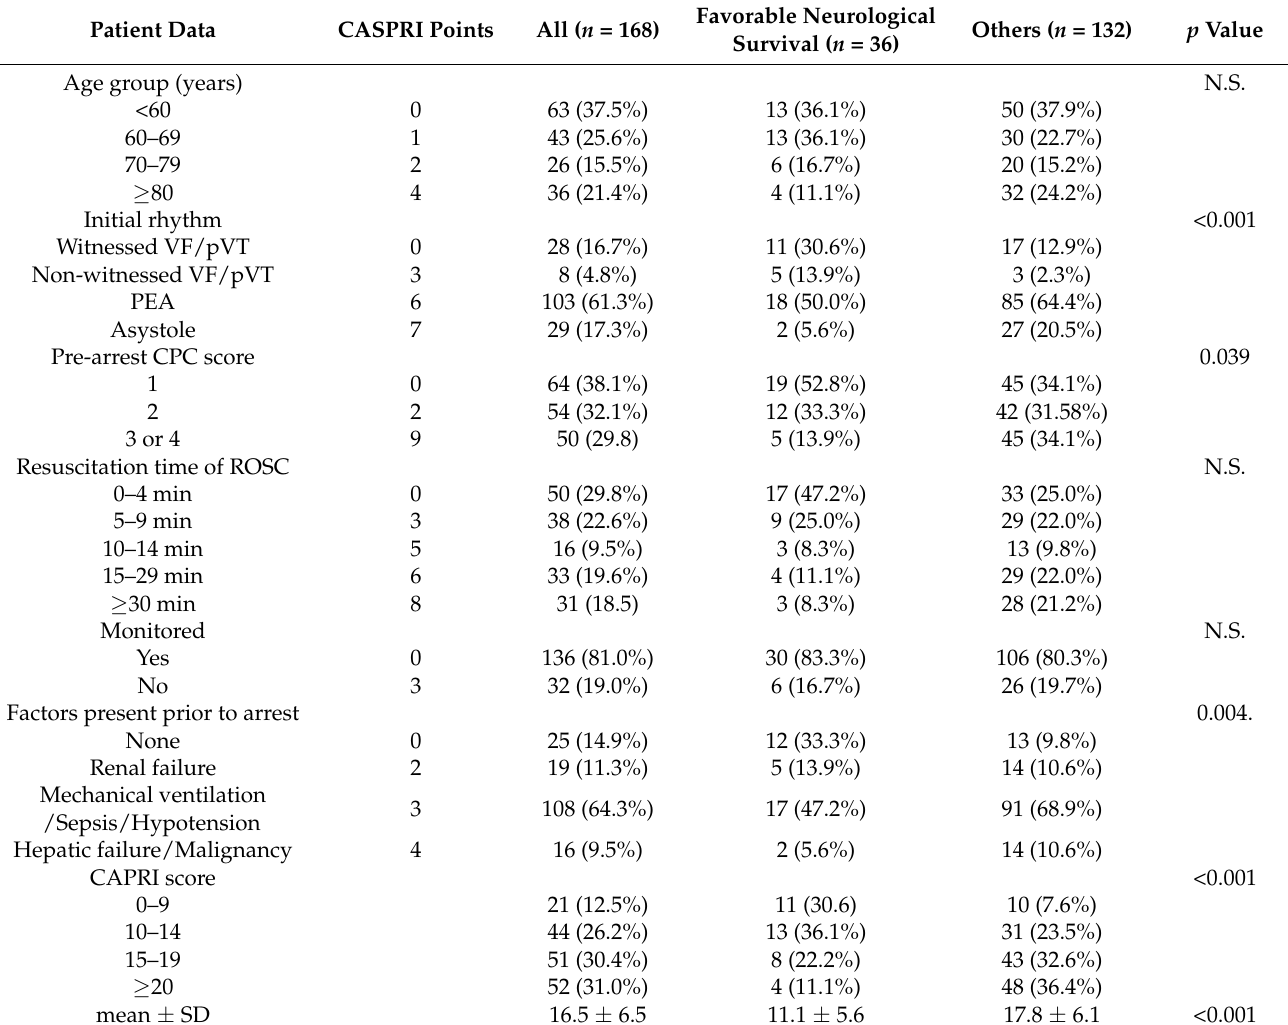
Table 3. The Cardiac Arrest Survival Post-Resuscitation In-hospital (CASPRI) predictors and favorable neurological survival in resuscitated